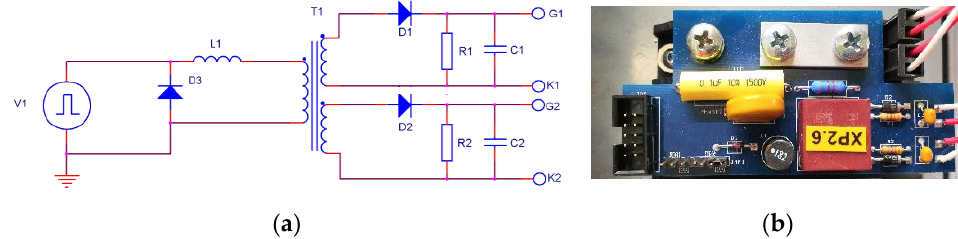
Figure 10. Typical circuit used for SCR drive with impulse transformer. ( a ) schematic circuit diagram ( b ) practical realization.